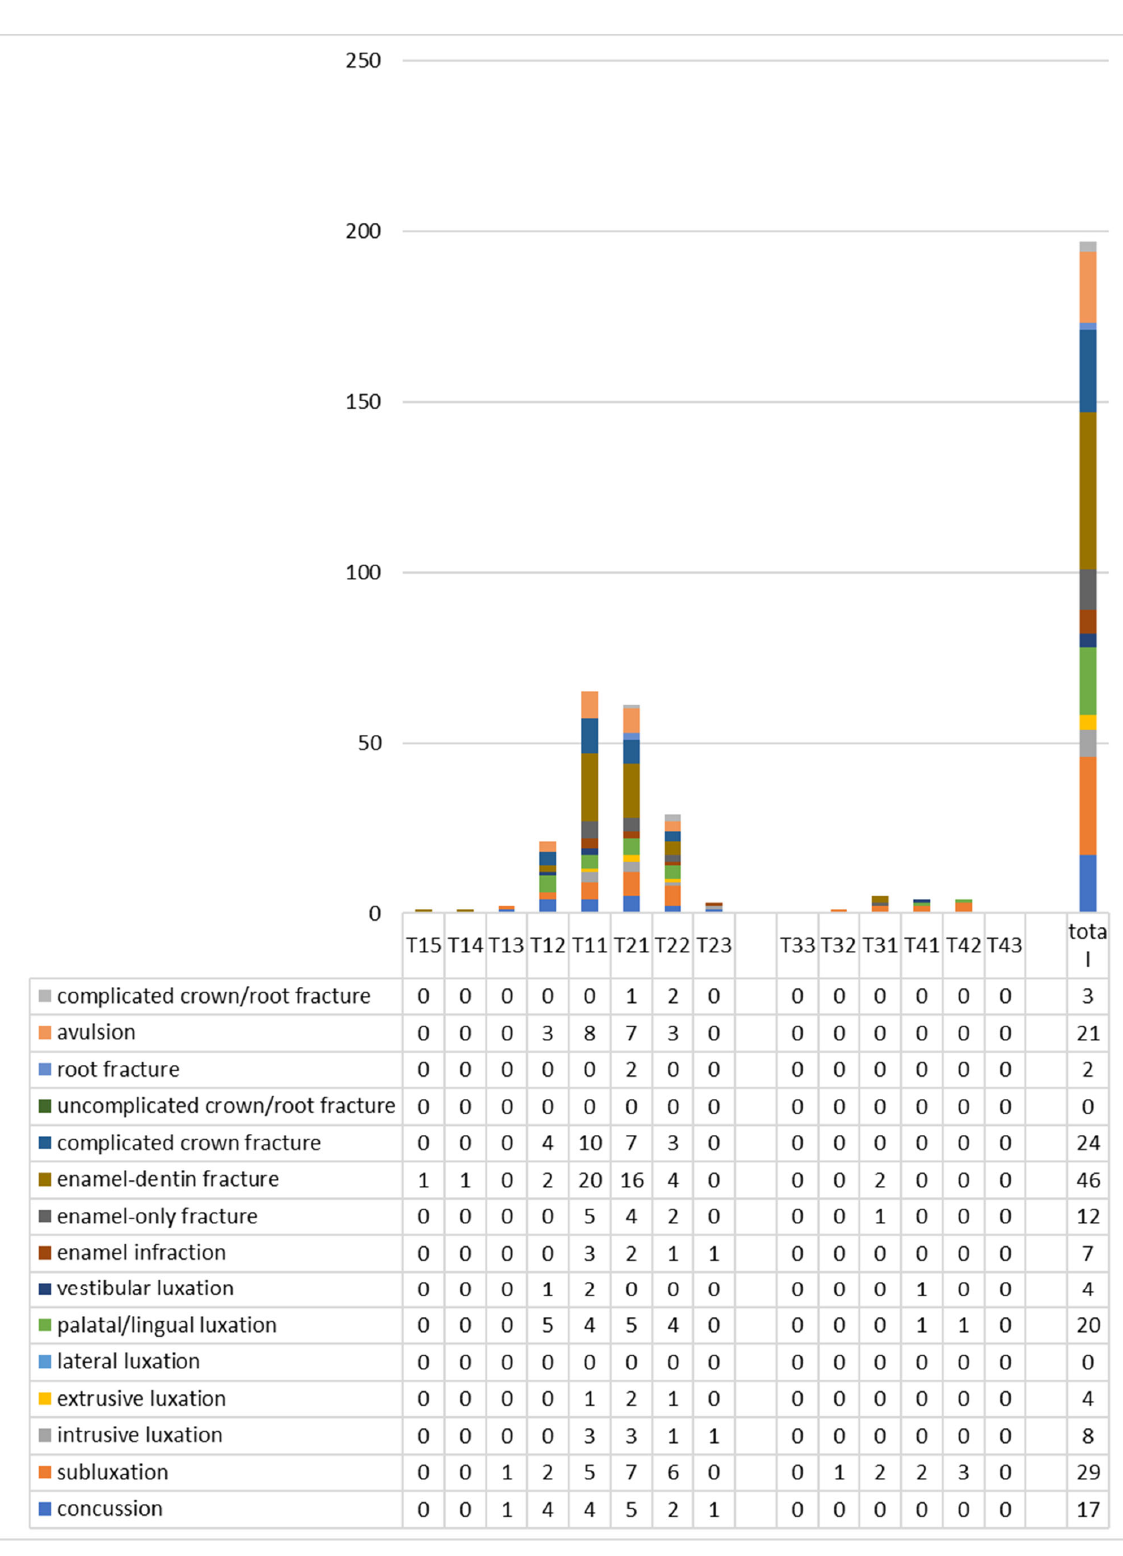
Figure 4. Distribution and types of injuries for permanent teeth. T15 stands for tooth 15, etc. The types of injuries differed between the two dentitions. On one hand, lesions to the periodontal ligament (luxation, 32%; subluxation, 23%; avulsion, 18%) were more common in deciduous teeth (Figure 3.). On the other hand, dental fractures (enamel or enamel